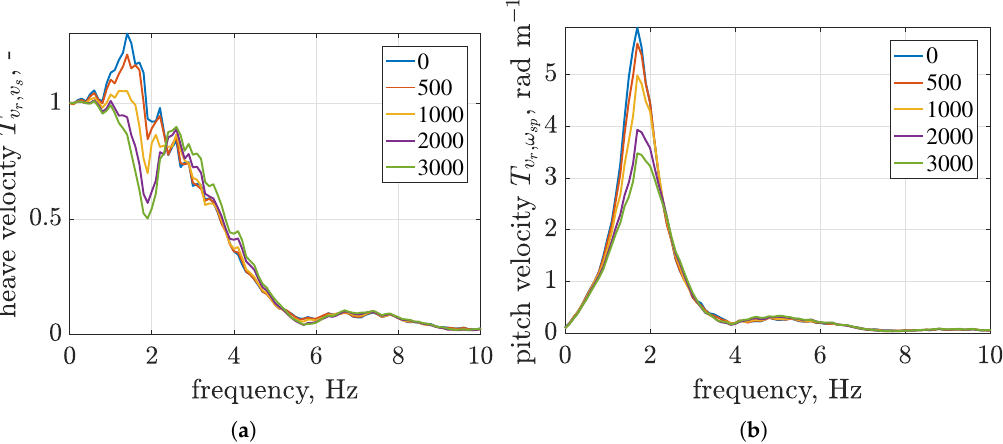
Figure 15. The transmissibility characteristics of the body dynamics for Skyhook control of the vibration modes (Skyhook-2DOF) at vehicle longitudinal velocity equal to 5 ms − 1 : ( a ) heave velocity, ( b ) pitch